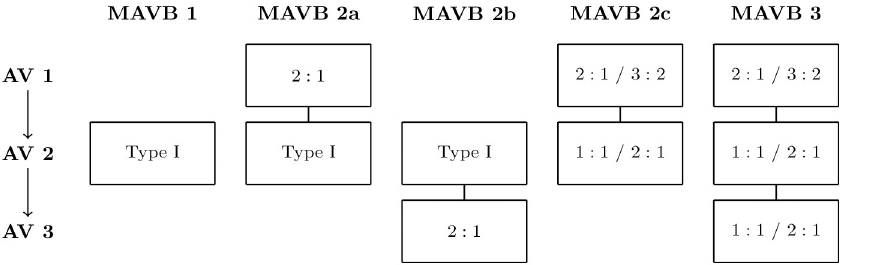
Fig 3. The five considered blocktypes, having up to three multilevel atrioventricular block (MAVB) levels.